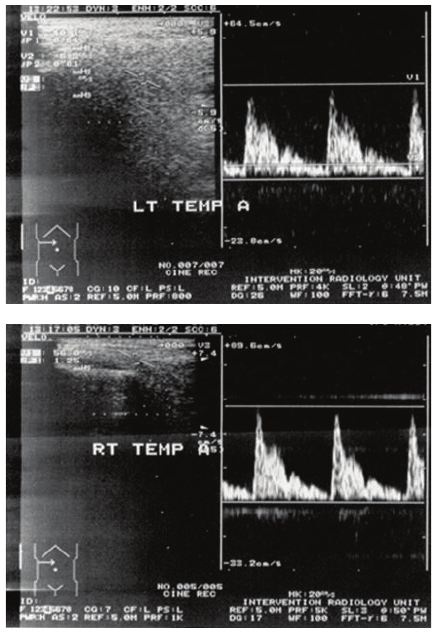
Figure 3: Duplex ultrasound of the temporal arteries. The diameter of the right temporal artery (RT TEMP A) was narrowed compared to the left (LT TEMP A). The resistive index was equal on